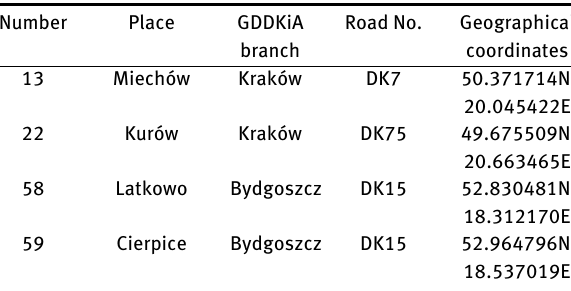
Table 1: Information on the location of the HS-WIM station Number Place GDDKiA